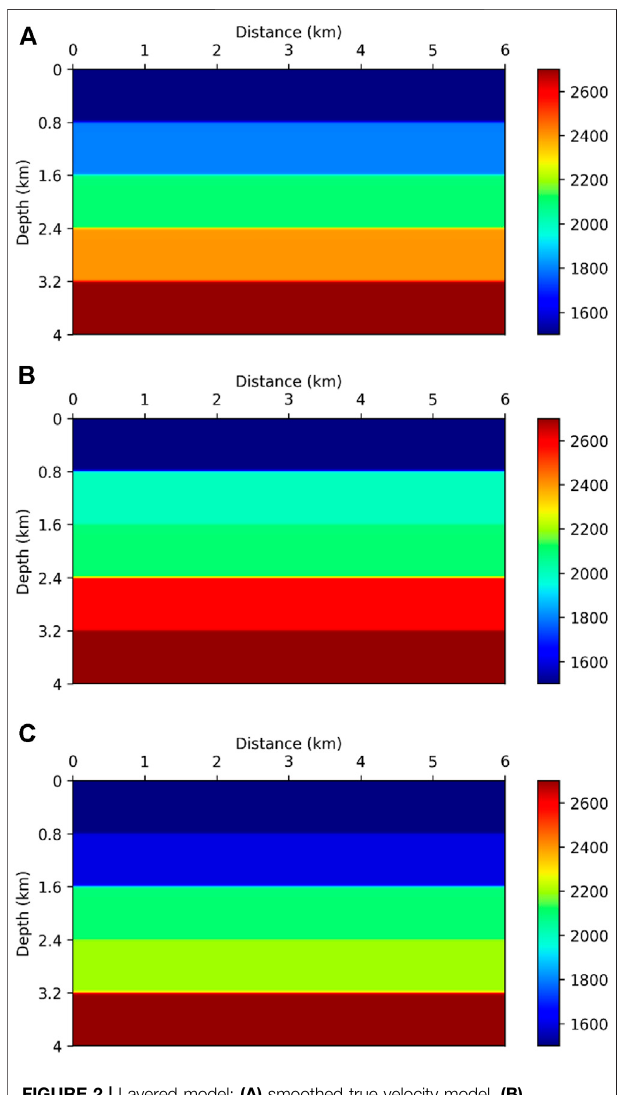
FIGURE 2 | Layered model: (A) smoothed true velocity model, (B) smoothed and increased velocity in 2nd and 4th layer model, and (C) smoothed and decreased velocity in 2nd and 4th velocity layer